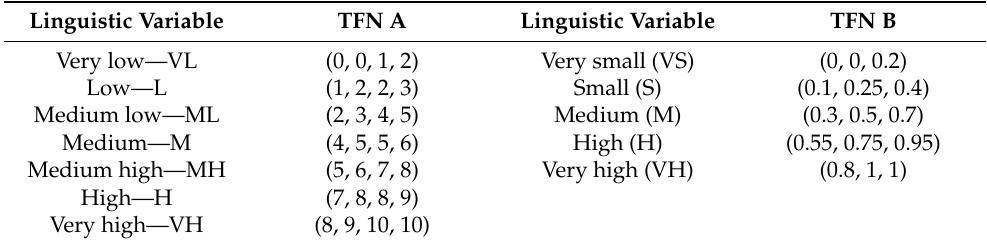
Table 5. Scale for evaluating order-picking technologies using the fuzzy EDAS-Z method. Linguistic Variable TFN A Linguistic Variable TFN B Very low—VL (0, 0, 1, 2) Very small (VS) (0, 0,